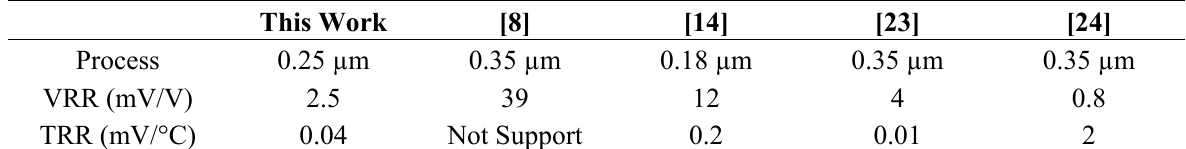
Table 3. Comparison with previous RF power